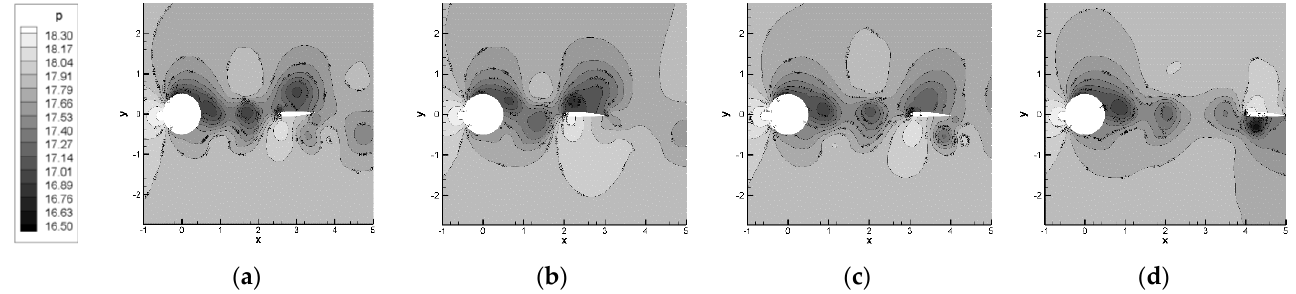
Figure 17. Pressure contour in different x / D ( T / T 0 = 0.5): ( a ) x / D = 1.75; ( b ) x / D = 2.0; ( c ) x / D = 3.0; ( d ) x / D = 4.0.